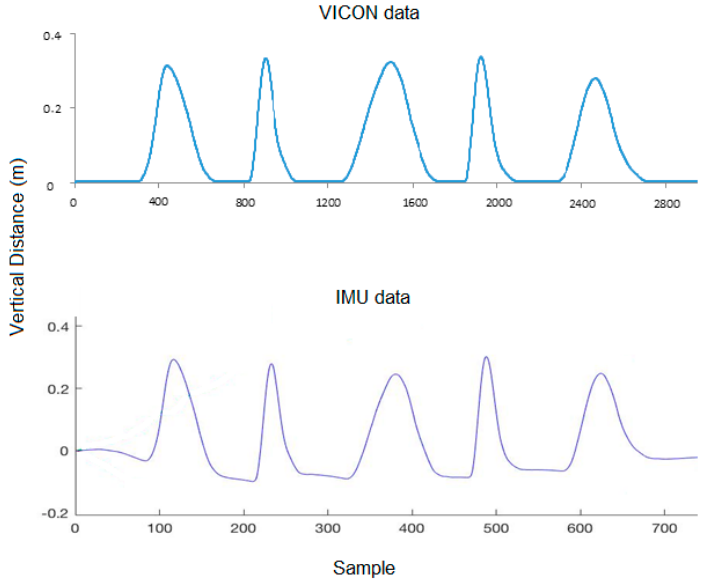
Figure 6. A renewed synchronized test data obtained from 3D motion capture (VICON data, top, sampling rate 200 Hz) and our IMU device after calibration (IMU data, bottom, sampling rate 50 Hz).